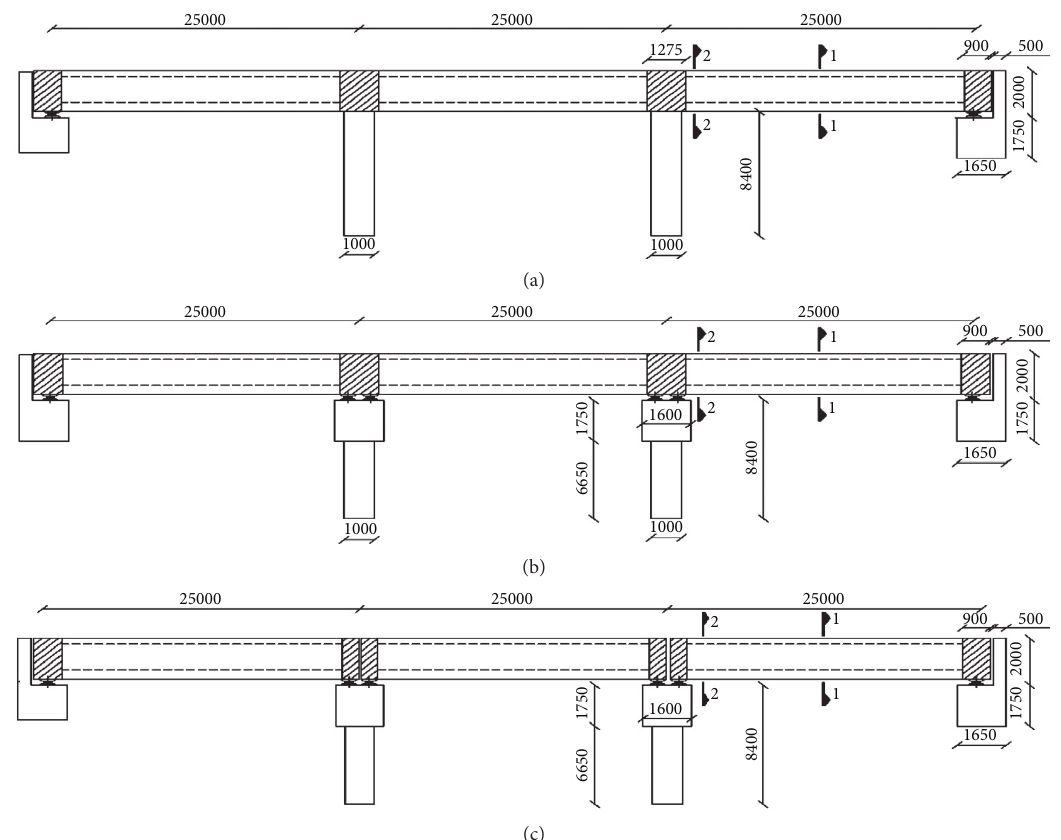
Figure 11: Layout of the box girder bridges. (a) Monolithic with columns; (b) continuous on bearing; and (c) simple box girder bridges on bearing.